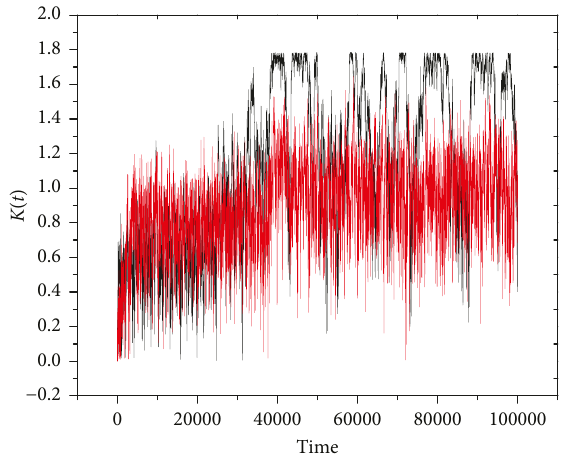
Figure 4: For bottom-up SOTC, the waiting-time PDF of the time intervals between two consecutive crossings of the horizontal line with 𝐾 = 0.7 (black and red line) and 𝐾 = 1.7 (blue line) for the top-down SOTC. The blue and the black lines describe the unperturbed case and the red line describes the perturbation described in Section